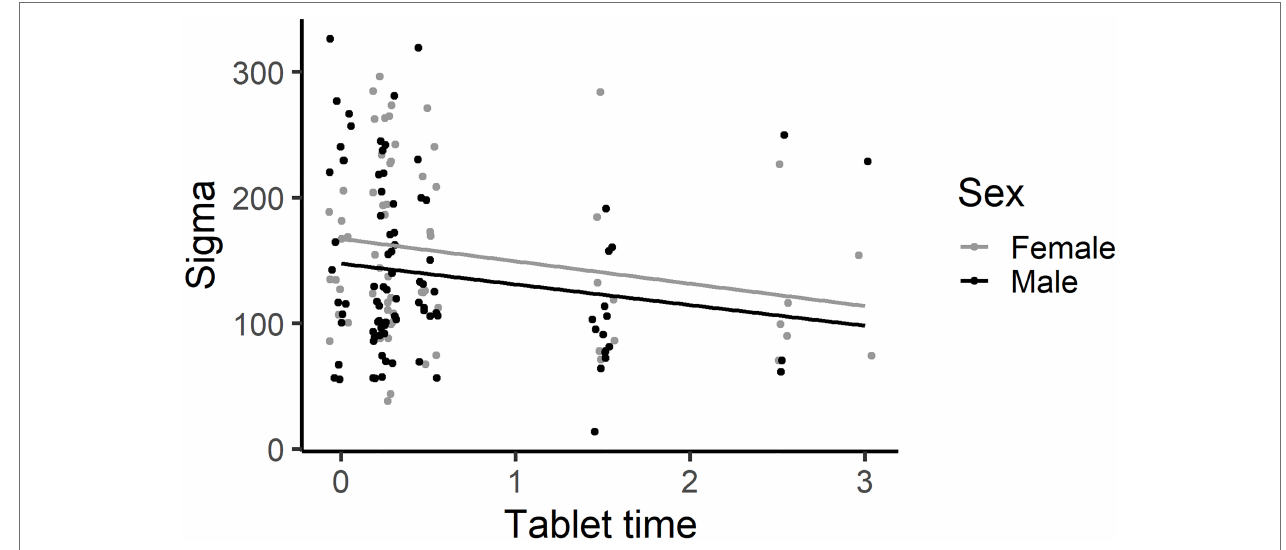
FIGURE 5 | The more time using a Tablet, the less variably the child responded on the SART. This graph has each individual’s data point shown, using